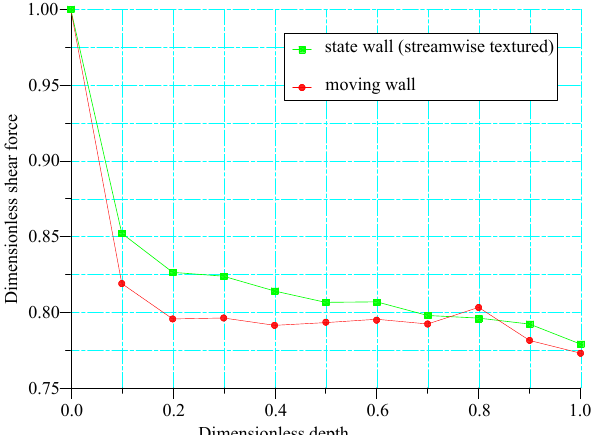
Figure 14. The effect of the depth of streamwise texture on the dimensionless shear